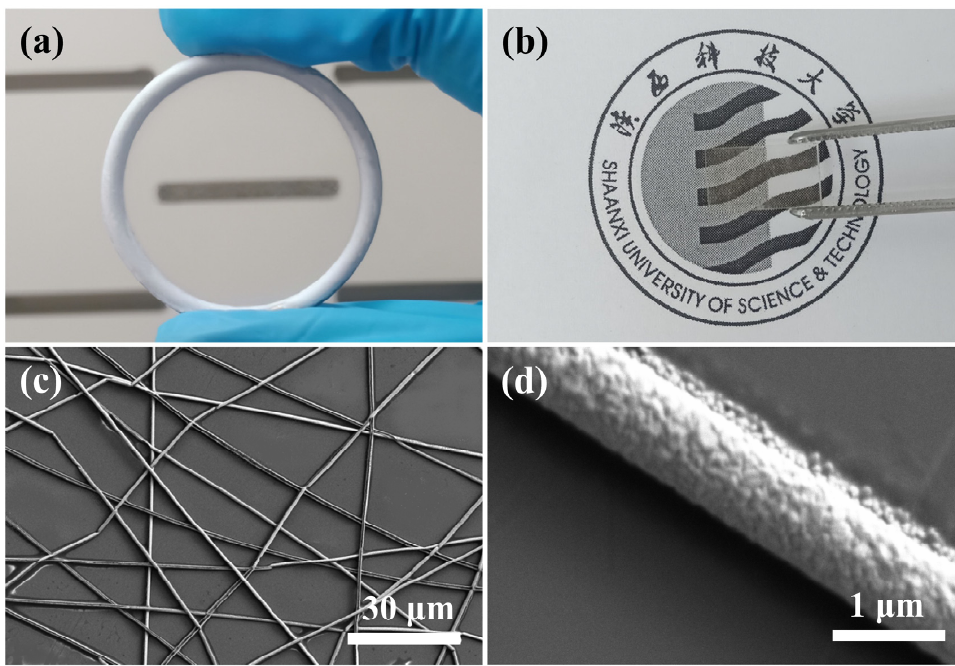
Figure 2. ( a ) Thin Ag film attached to the collection ring. ( b ) The AgTCF obtained by transferring AgNWs to a quartz substrate. ( c ) FESEM image of Ag nanonetworks. ( d ) FESEM morphology of single AgNW.